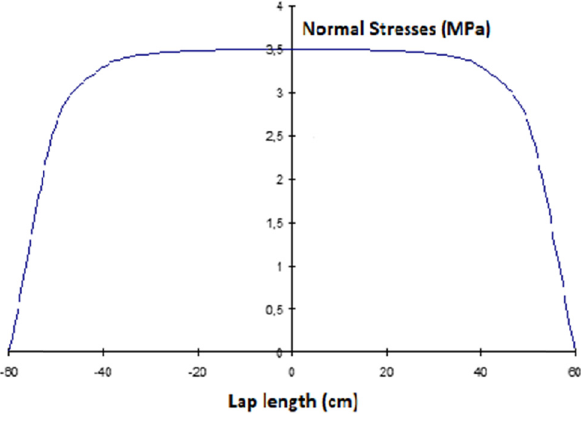
Figure 6: Variation of the normal stress along the bonded plate.